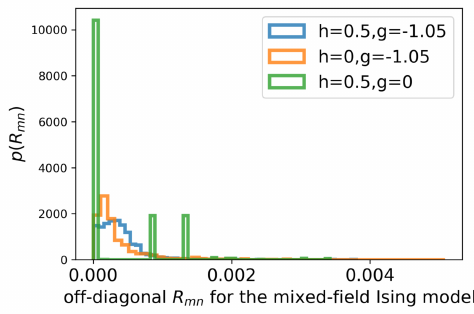
Figure 28 . Distributions of ECH matrix elements for the mixed-field Ising model in the integrable, integrable-interacting and chaotic regimes, calculated using spin chain of length N = 9 , with k = 2 - local operators taken as simple.